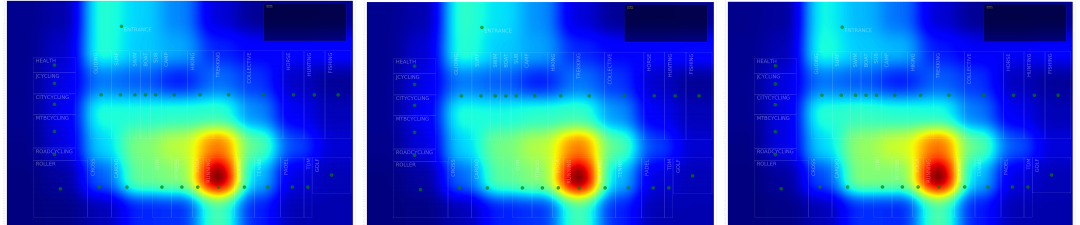
Figure 7. General heat map ( left ). Week ( center ). Weekends ( right ).